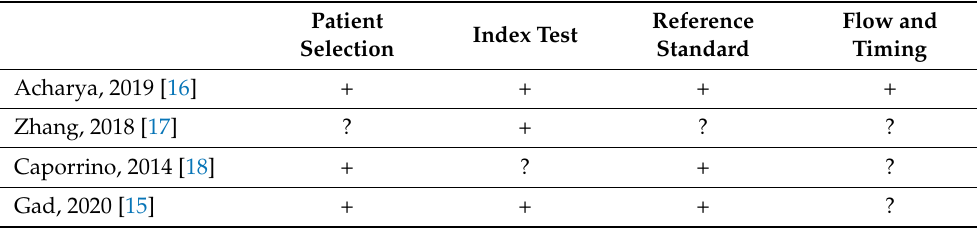
Table 2. Quality assessment of diagnostic accuracy studies (QUADAS)-2, quality assessment of the included